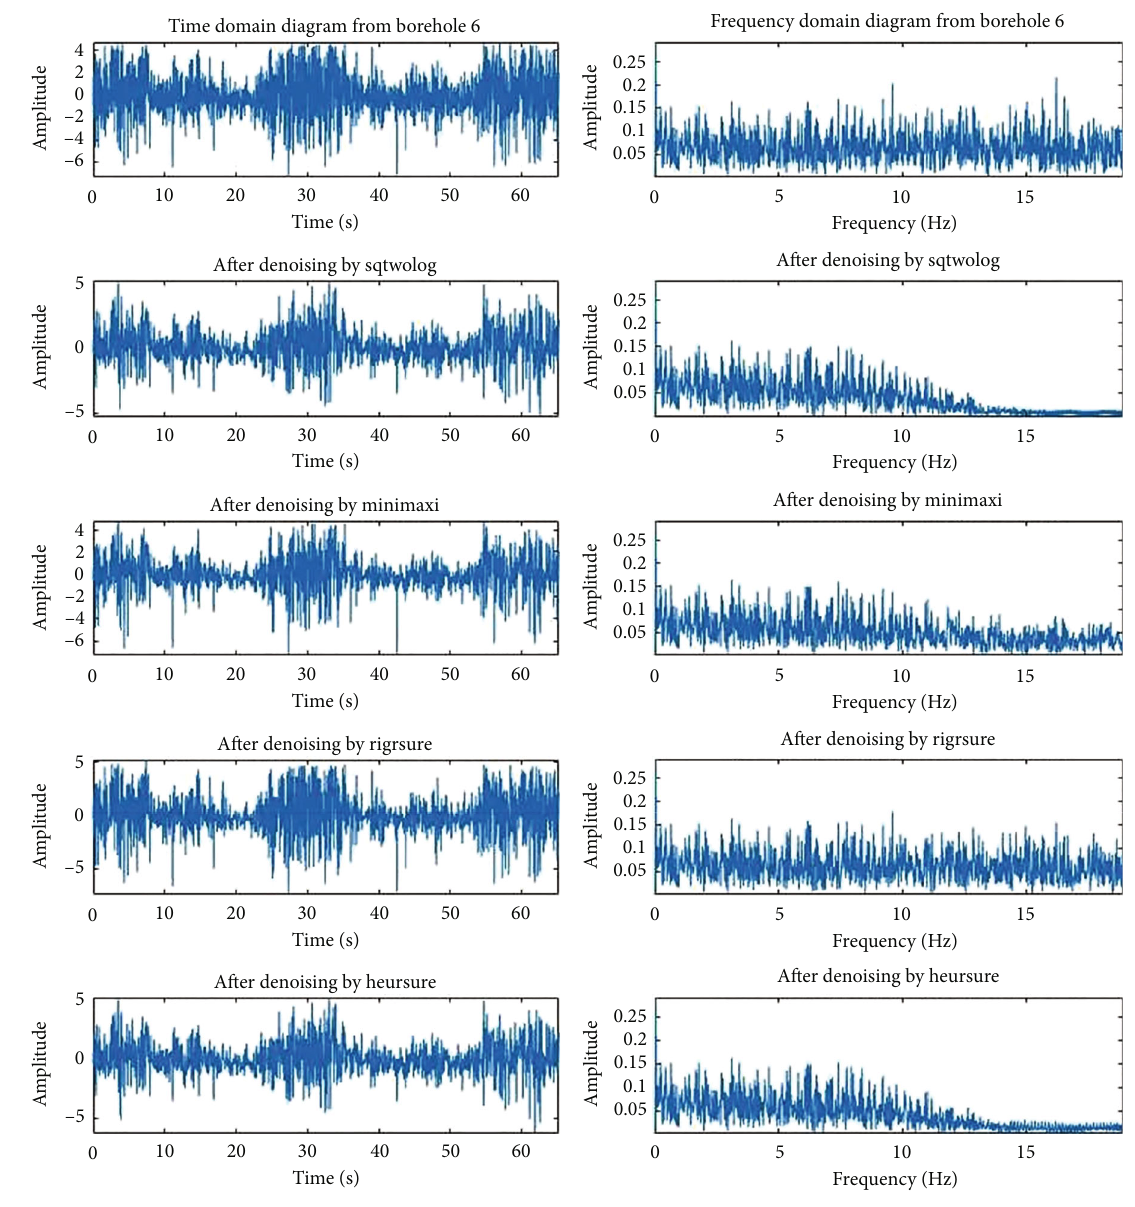
Figure 11: Denoising e ff ect diagram of four threshold rules. Table 1: Comparison of threshold denoising